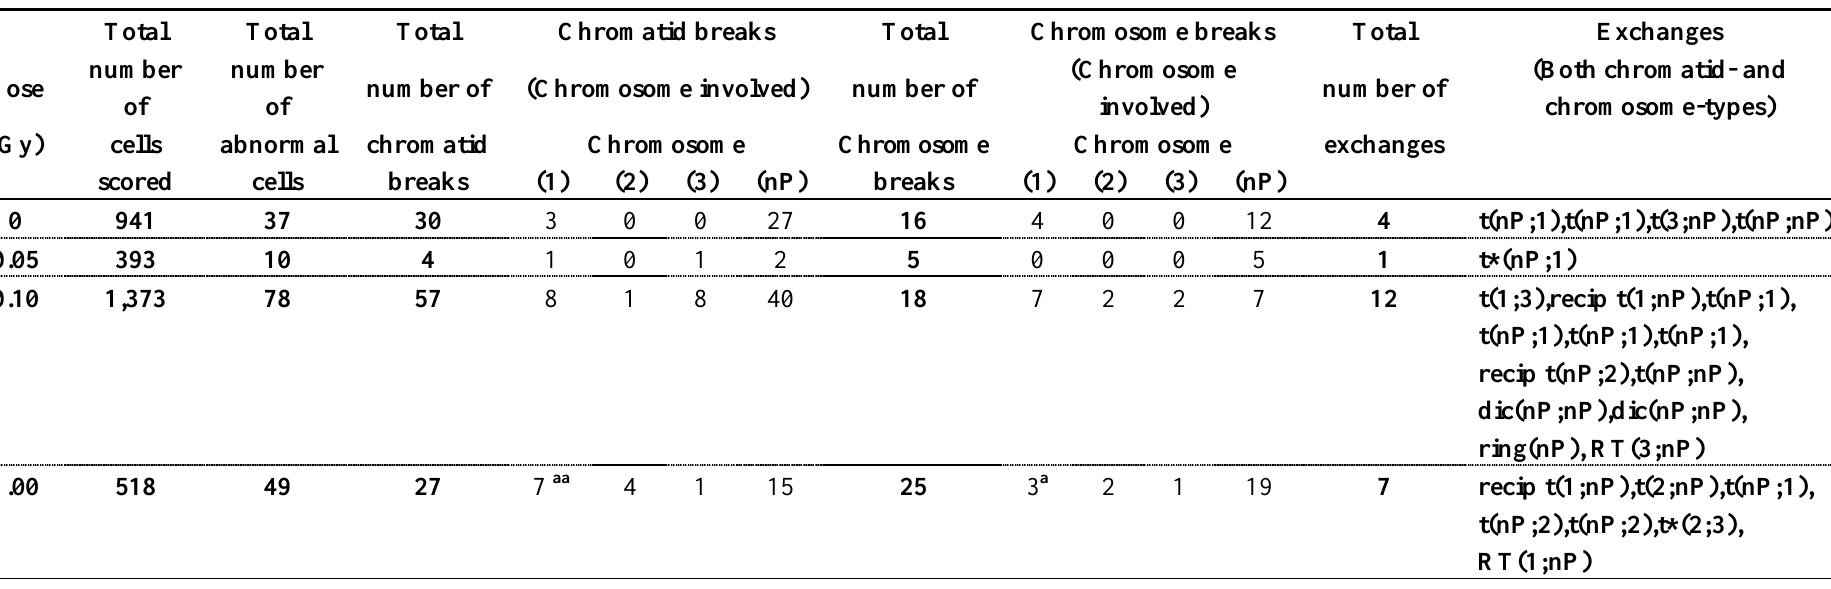
t Translocation (incomplete, chromosome-type), t * Translocation (incomplete chromatid-type), recip t Reciprocal translocation, RT Robertsonian translocation, dic Dicentric, ins Insertion, nP non-painted chromosome, a clones of cells with a specific type of aberration occurring on a specific chromosome found in one mouse; aa clones of cells with a specific type of aberration occurring on a specific chromosome found in two